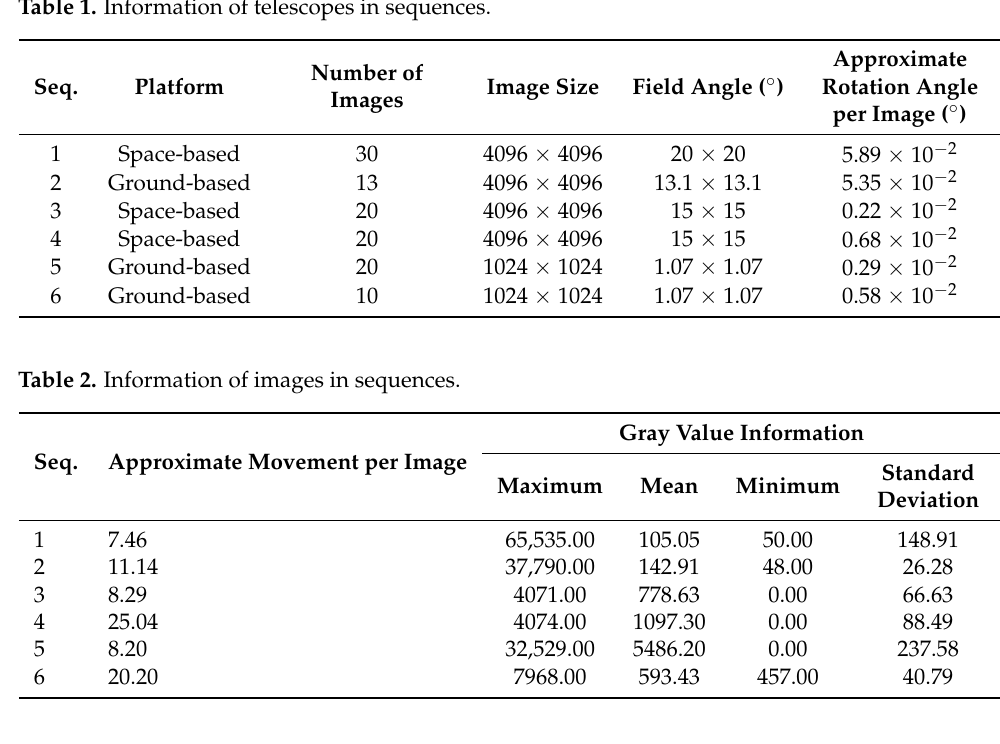
Figure 5. Real astronomical image sequences. ( a ) Seq.1, ( b ) Seq.2, ( c ) Seq.3, ( d ) Seq.4, ( e ) Seq.5, and ( f ) Seq.6. Table 1. Information of telescopes in sequences.